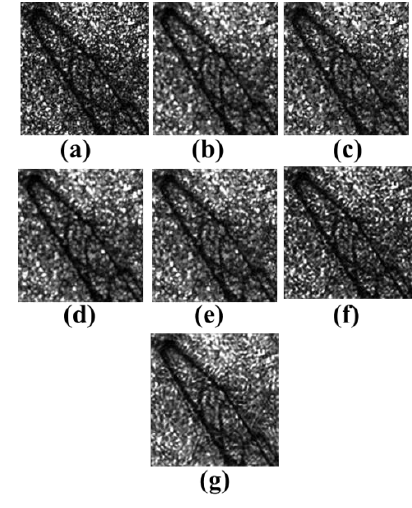
Figure. 3: Despeckling results of different filters for ENVISAT image: (a) ENVISAT Image, (b) Frost, (c) Gamma, (d) Kuan, (e) Lee, (f) K-sigma, (g) Proposed